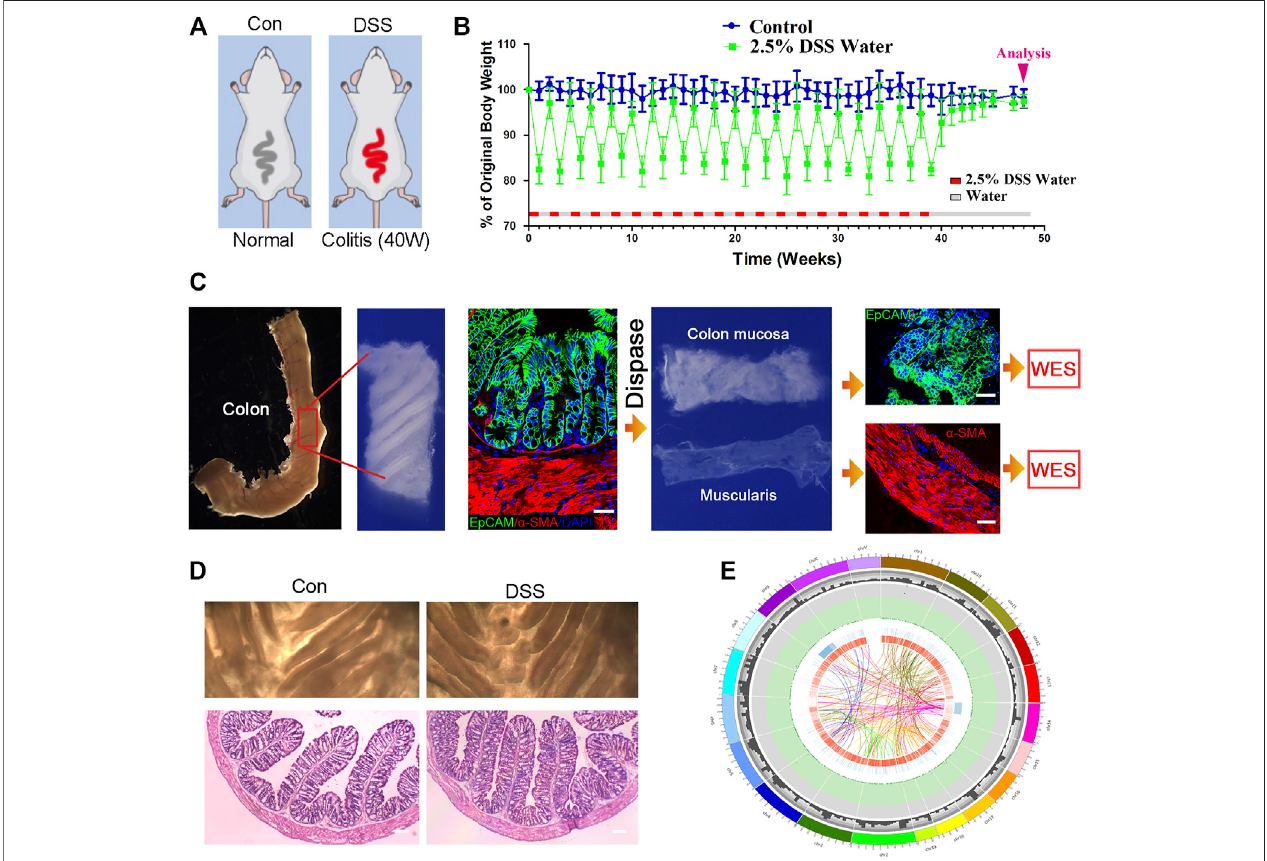
FIGURE 1 | Establishing chronic in fl ammation model for genomic sequencing assay. (A, B) Schematic for dextran sulfate sodium (DSS)-induced colitis, and the procedure of DSS treatment to induce chronic colitis. n (cid:2) 12 for DSS-treated mice and n (cid:2) 10 for control mice. (C) The procedure of colon mucosa and muscularis isolation, and the isolated mucosa and muscularis were subjected to whole-exome sequencing (WES). Scale bar: 50 μ m. (D) Colons were separated in both DSS- treated mice and the age-matched control mice; no obvious morphological difference was found the two groups with dissecting microscope, neither in histopathology. n (cid:2) 6 for both control and DSS-treated mice, and representative results are shown. Scale bar: 50 μ m. (E) Circos imaging of the overview result of WES, showing (from outside to inside) the length of the genome, the number of genes within 10 M, the frequency of single-nucleotide polymorphisms (SNPs) within 1M (red squaresover0.0015andgreentrianglesbelow0.0005),INS(insertion),INV(inversion),ITX(intrachromosomaltranslocation),andCTX(interchromosomaltranslocation).